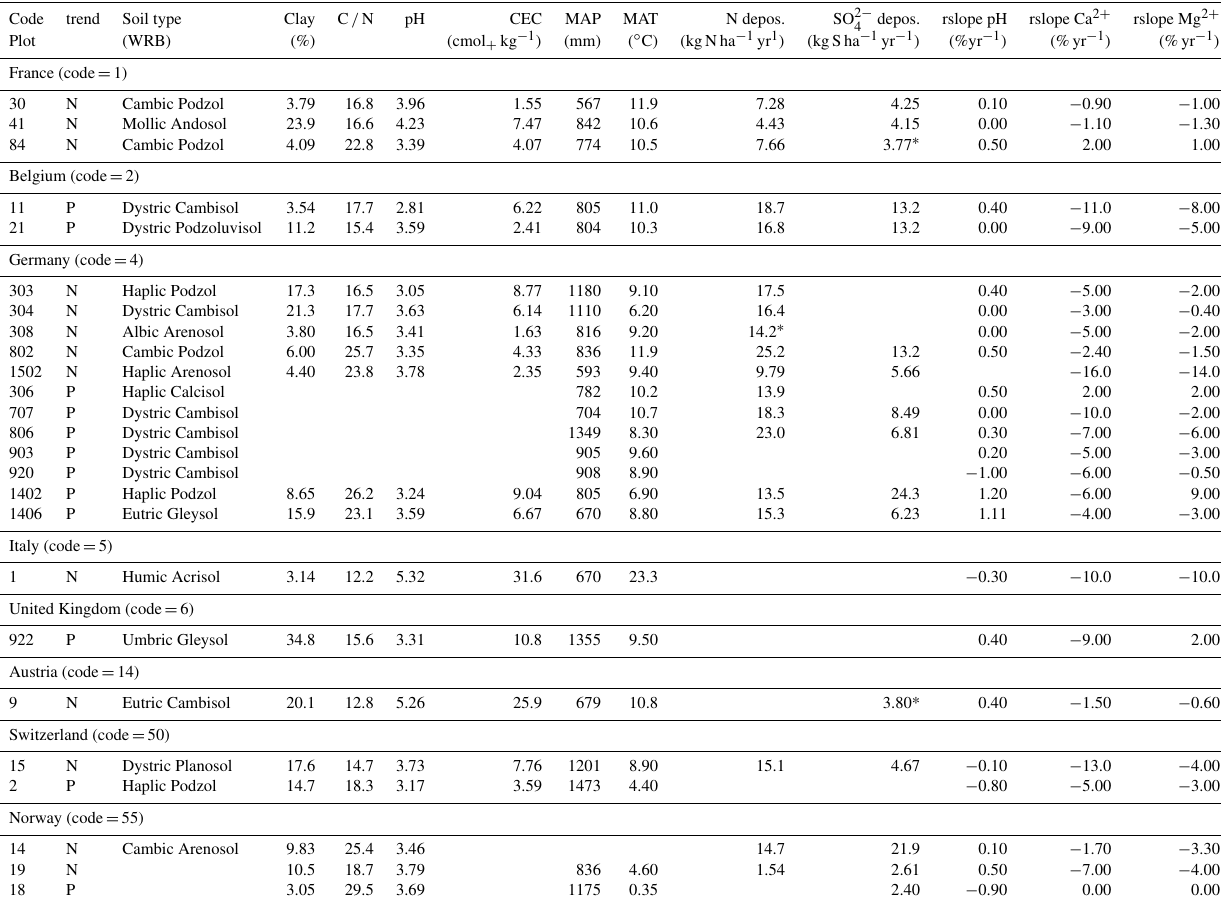
Table 2. Site properties for the 13 plots showing consistent negative trends (N) of DOC concentrations and for the 12 plots showing consistent positive trends (P) of DOC concentrations. Soil properties (clay percentage, C / N ratio, pH(CaCl 2 ) , cation exchange capacity (CEC)) are for ) is throughfall deposition from 1999 to 2010. When the soil depth interval 0–20cm. Mean atmospheric deposition (inorganic N and SO 2 − 4 throughfall deposition was not available, bulk deposition is presented with an asterisk. Relative trend slopes (rslope) in soil solution pH, Ca 2 + and Mg 2 + concentrations were calculated using the seasonal Mann–Kendall